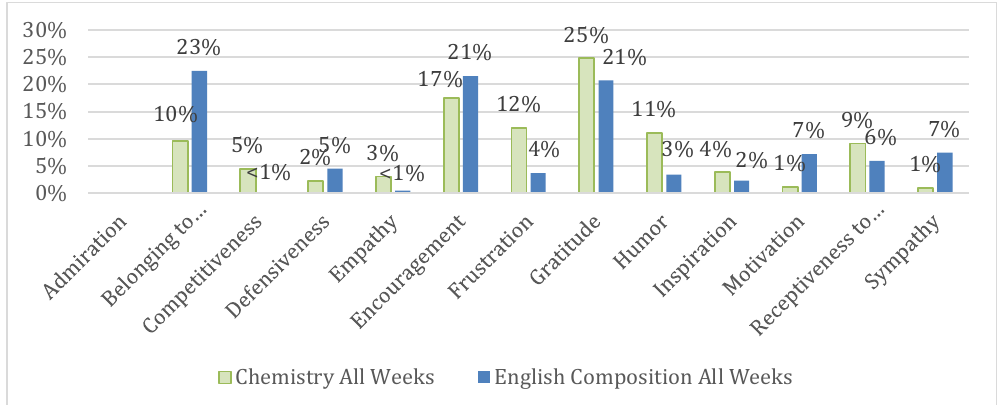
Figure 2. Percentages of posts coded to affects and emotions in weekly forums.